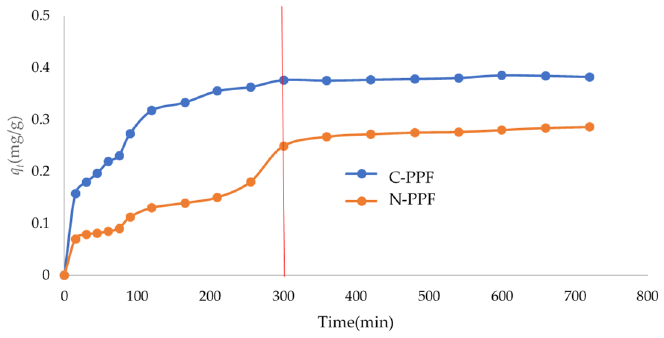
Figure 6. Variation in percentages of Fe(III) removal with contact time.